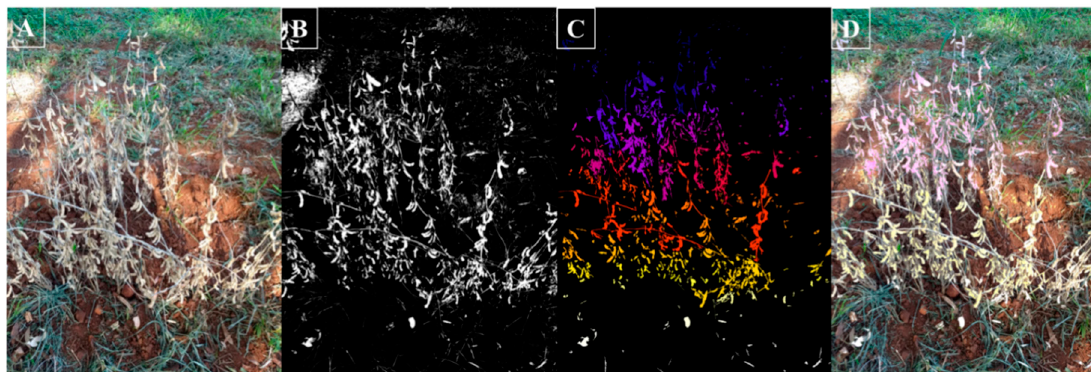
Figure 4. Example of computer vision technique application to gather soybean number of grains on-field situations. ( A ) Original soybean image, ( B ) soybean image transformation, ( C ) surface object detection image and ( D ) original soybean image overlaid with surface object detection